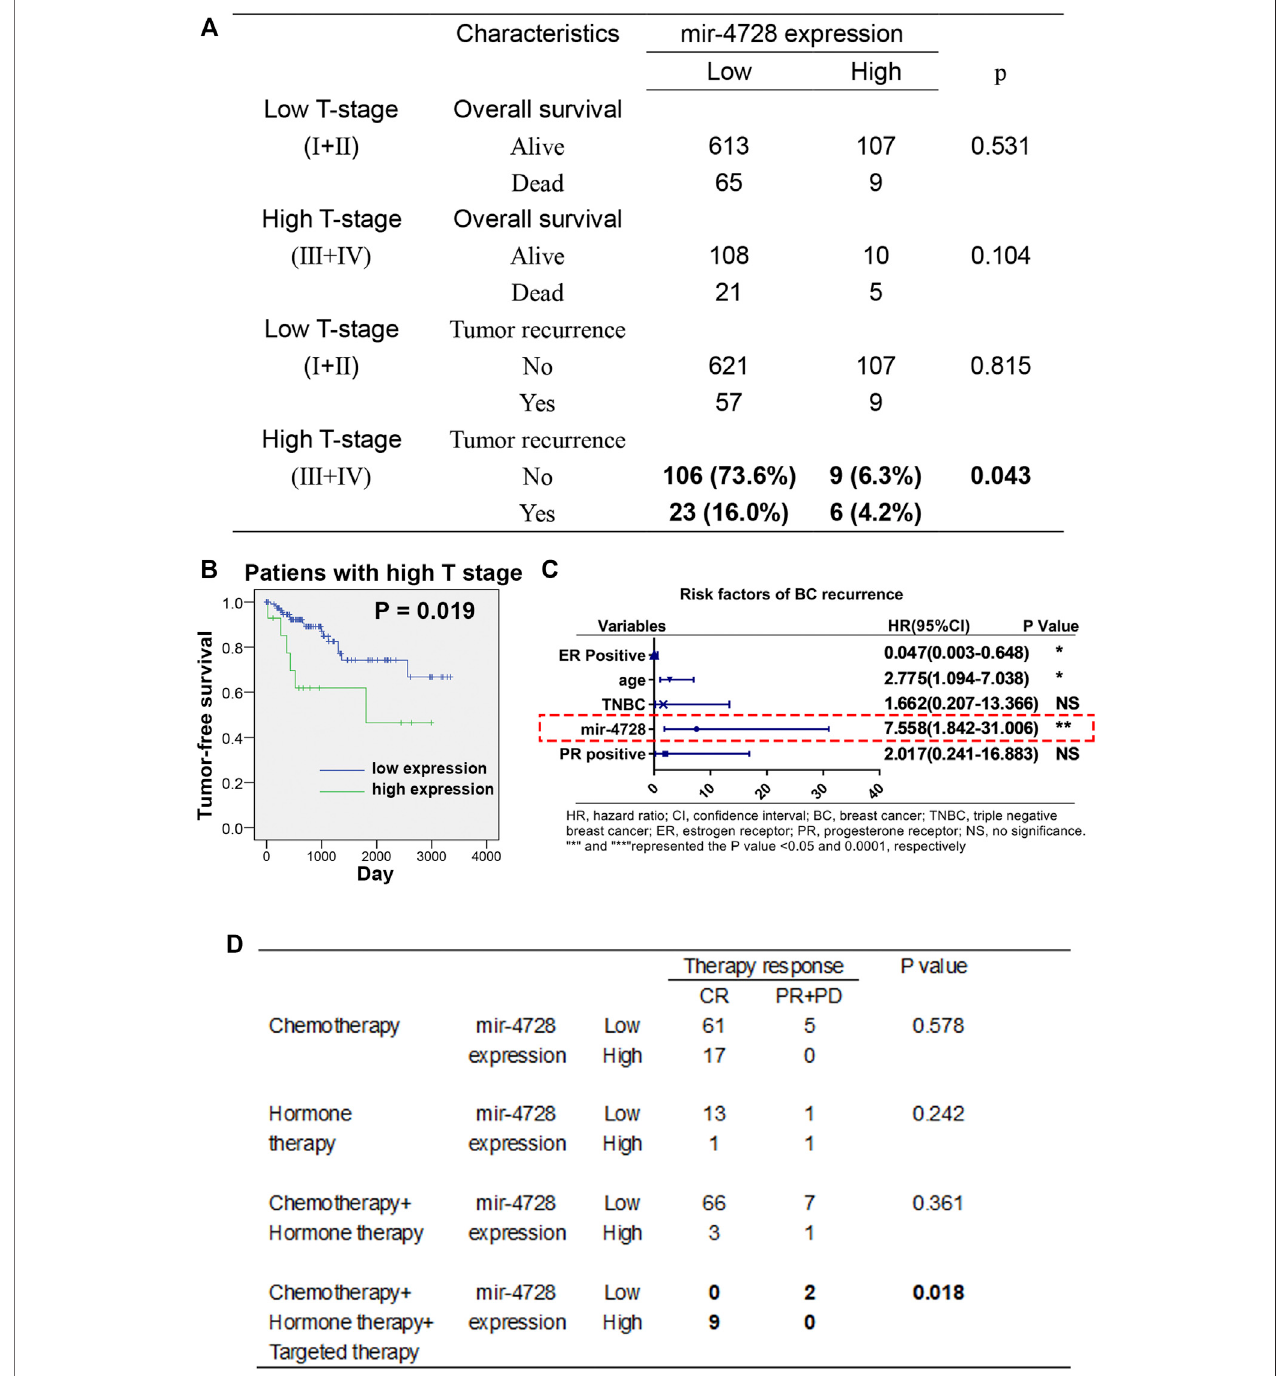
FIGURE 2 | Potential clinical implication of mir-4728 in breast cancer patients. (A) Correlation analysis between the mir-4728 expression and tumor recurrence in breastcancerpatientsatthehighTandlowTstages. (B) Log-rankstatisticsshowthathighmir-4728expressionpredictsearlytumorrecurrenceinthepatientswithhigh T stage. (C) Independent risk factors of tumor recurrence in patients at high T stage. (D) Correlation analysis between the mir-4728 expression and therapy response in the patients with different therapeutic strategies.